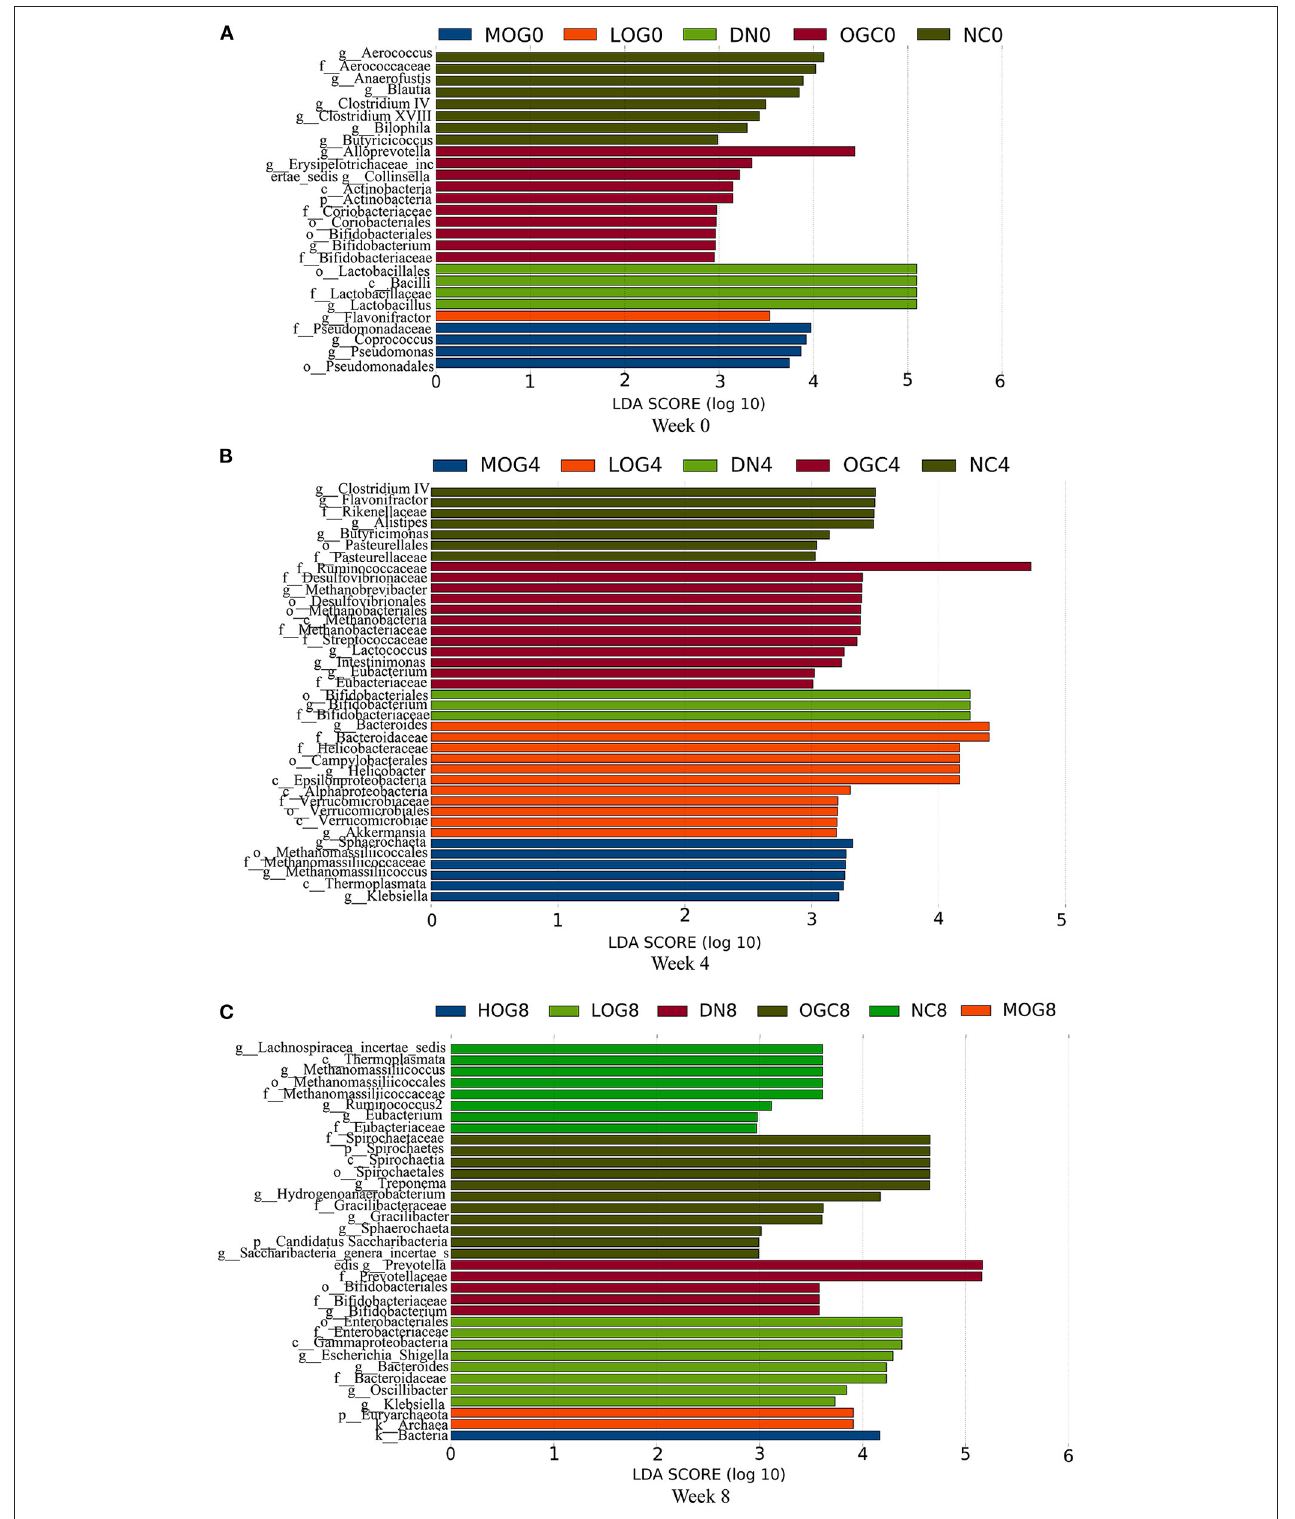
FIGURE 8 | LEfSe significant differences in abundance (LDA score > 2) of the rats in each group at 0 (A) , 4 (B) , and 8 (C) weeks.